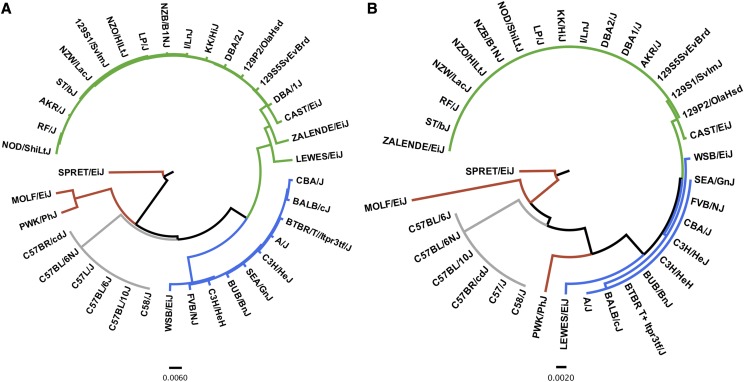
Phylogenetic analysis of the genetic and amino acid sequences for the Ahr of 37 inbred mouse strains. Trees were derived from a multiple sequence alignment of A) genetic sequences or B) amino acid sequences using the Multiple Alignment using Fast Fourier Transform (MAFFT) software (Katoh et al. 2005). Trees are rooted on SPRET/EiJ. Gray indicates Ahrb1 mice, blue indicates Ahrb2 mice, orange indicates Ahrb3 mice, and green indicates Ahrd mice. Scale bar indicates relative distance for each tree.